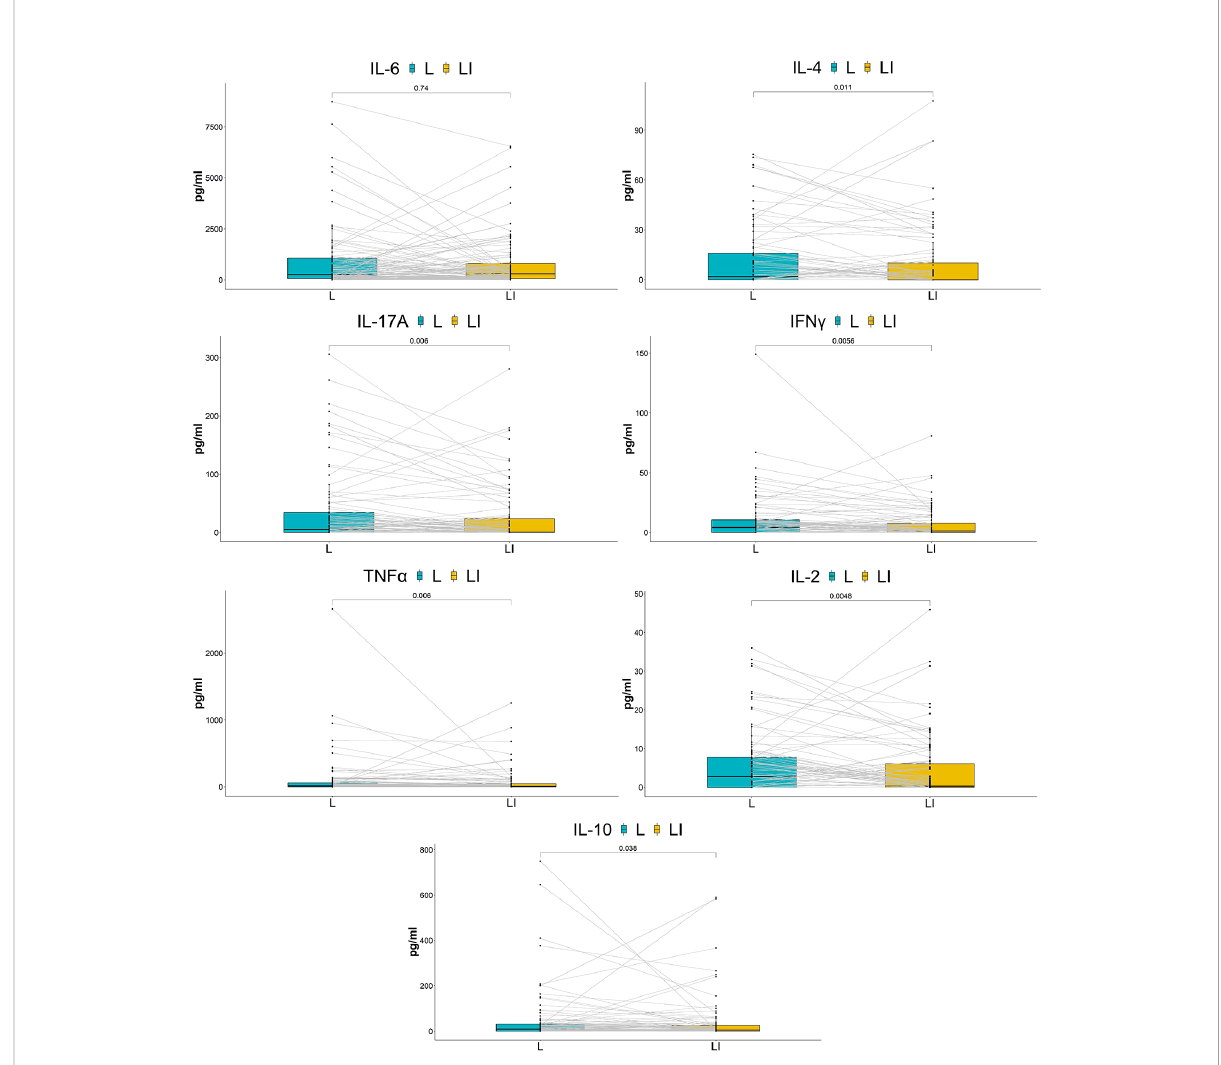
FIGURE 4 Comparison of cytokine concentrations between baseline and after seven times of treatment. The box plots show the change in cytokine concentrations between groups. P -values above the fi gure were generated using two-sided paired Wilcoxon signed-rank tests. The bounds of boxes show the interquartile range with the lower and upper hinges corresponding to the 25th and 75th percentiles, respectively. Points beyond that were plotted